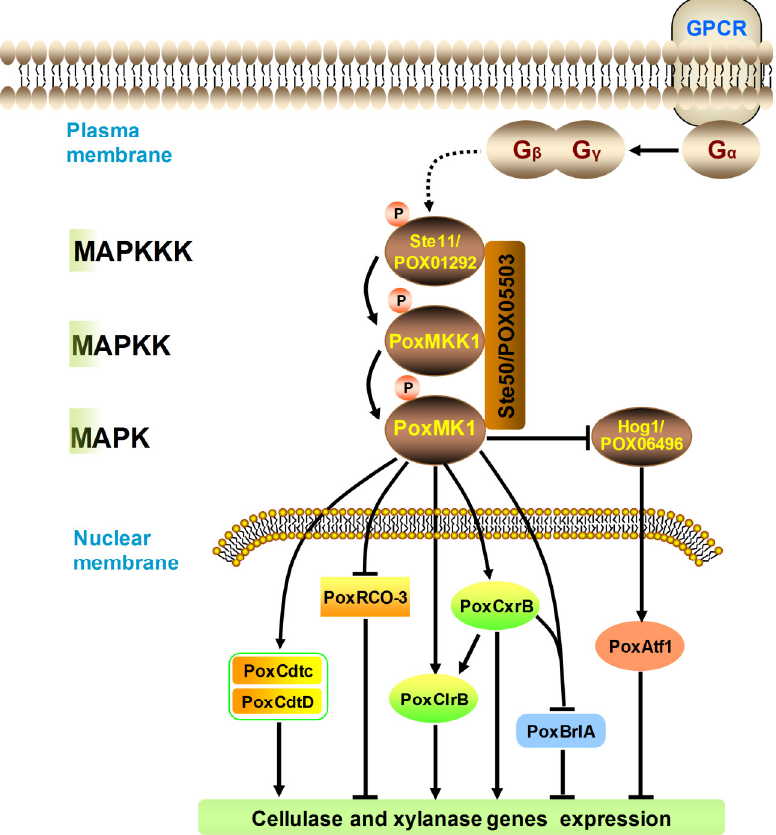
Figure 8. Schematic model for the regulatory network of protein kinase PoxMKK1 in P. oxalicum according to the data. GPCRs, G protein-coupled receptor. A P in orange-red circles represents phosphorylation events. The dashed lines represent that the pathway needs to be further confirmed. Arrows indicate activation, whereas bars indicate repression.